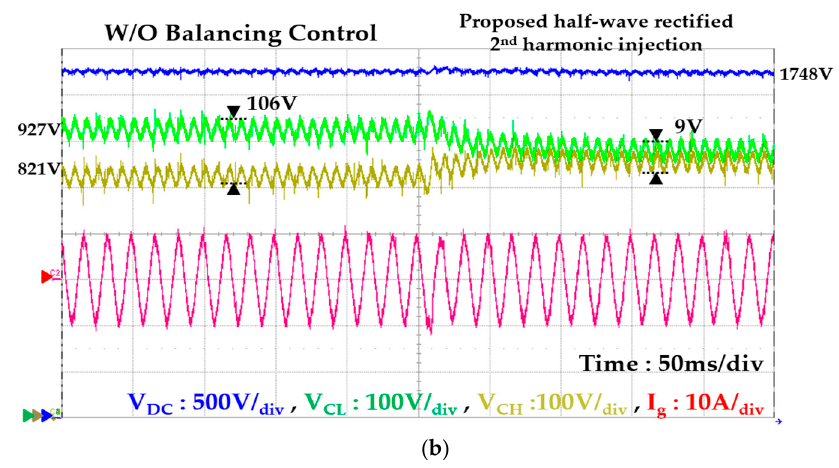
Figure 11. Experimental results for the single-phase NPC inverter with V DC , V CH , V CL and i g ( a ) using second-order harmonic component; and ( b ) using subdivided wave of second-order harmonic component.